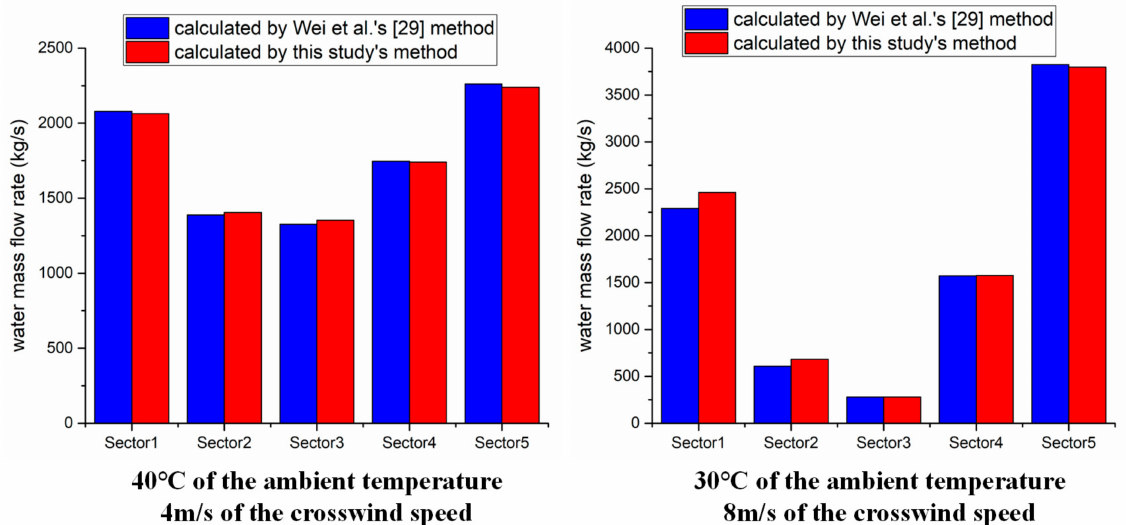
Figure 8. Comparison of the optimal circulating cooling water